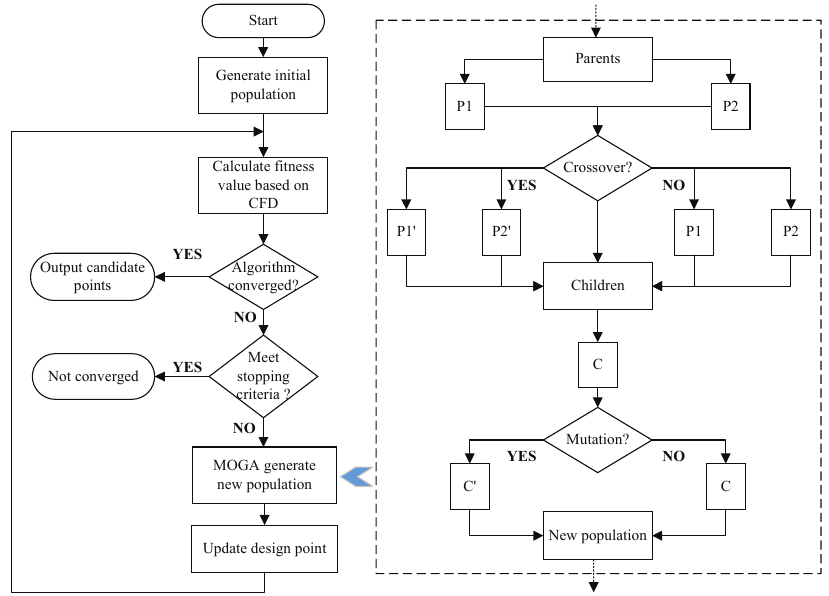
Figure 5. Flow chart of parameter optimization based on a MOGA.